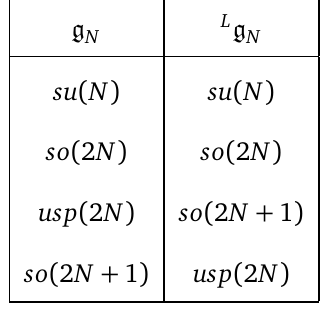
Table 2: Duality relations of relevance to this